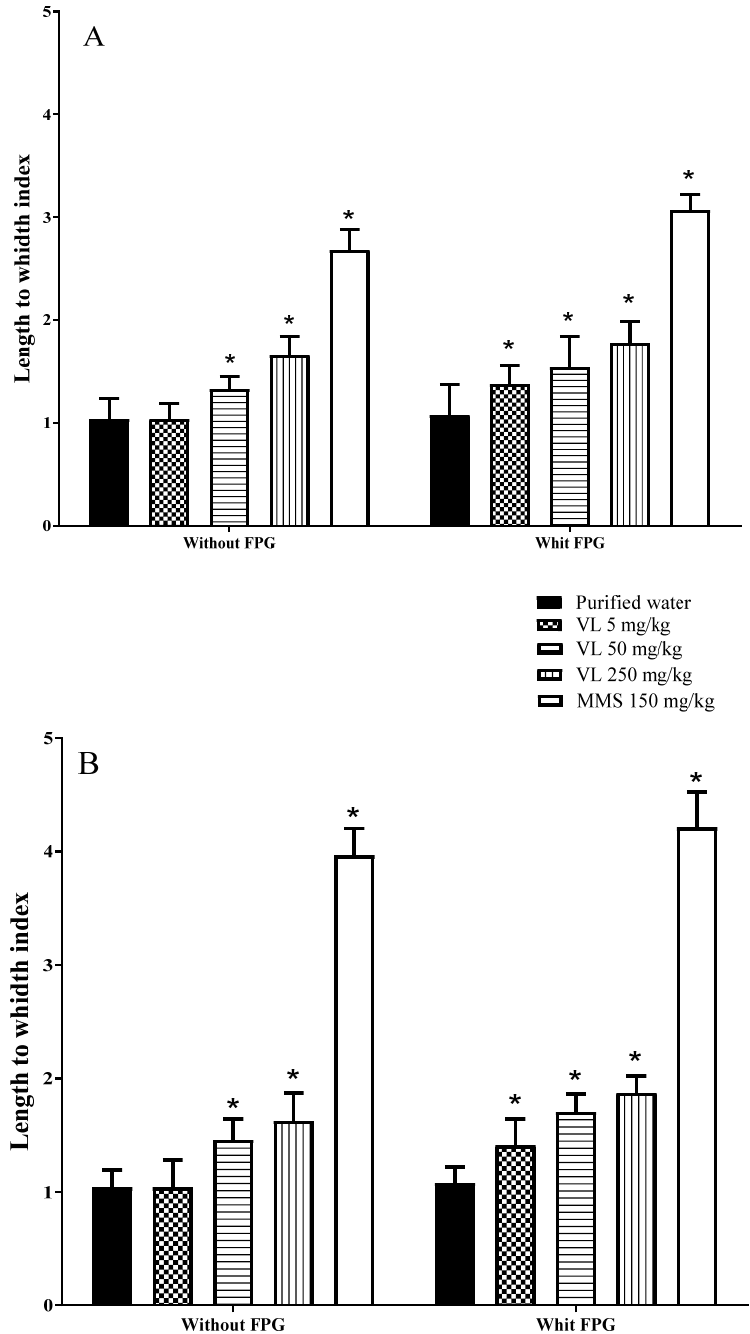
Figure 2. DNA damage induced at 2 h of venlafaxine (VL) exposure without and with the FPG enzyme. In the brain of mouse ( A ) and in mouse hepatic tissue ( B ). MMS = methyl methanesulfonate. Each bar represents the mean ± SDM obtained in 100 nucleoids per mouse. Five mice per dose. * Shows statistically significant difference in comparison with the control level. Two-way ANOVA and Tukey tests ( p ≤